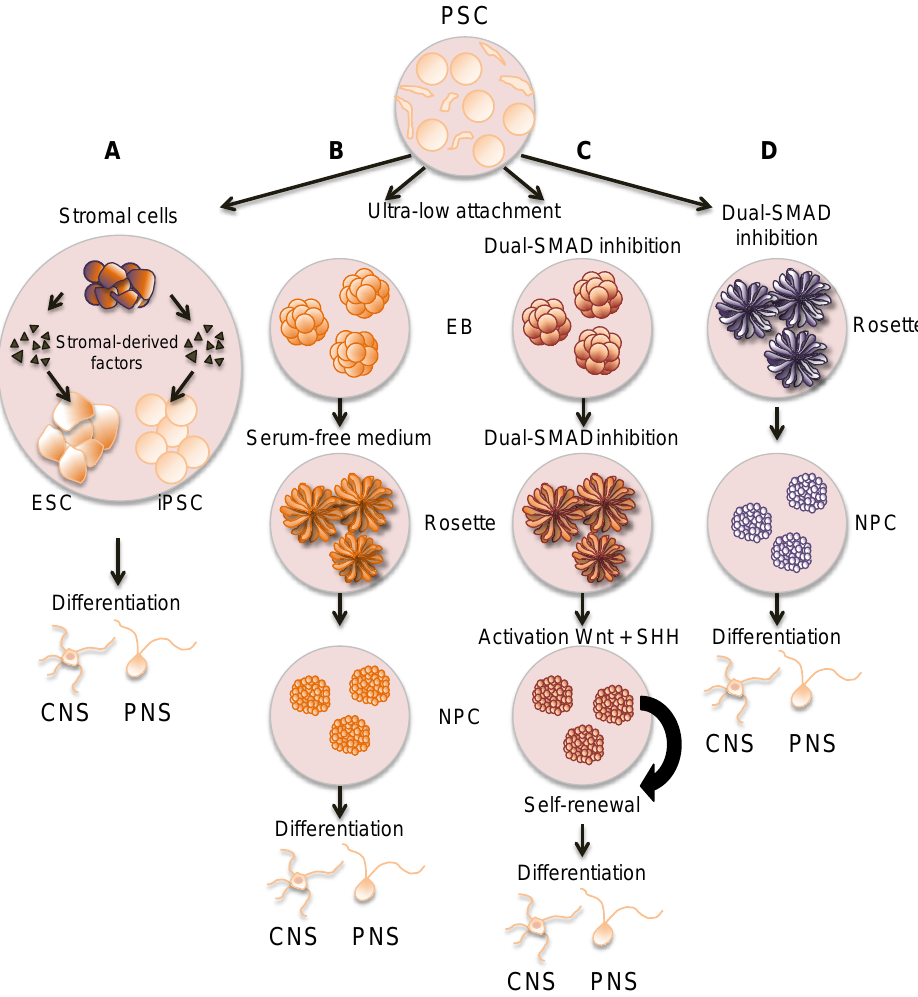
Figure 1. Derivation of human neurons from pluripotent stem cells (PSC). Schematic representation of the main procedures to generate human neurons from PSC, including embryonic stem cells (ESC) and induced pluripotent stem cells (iPSC). ( A ) Stromal cells release factors that facilitate the